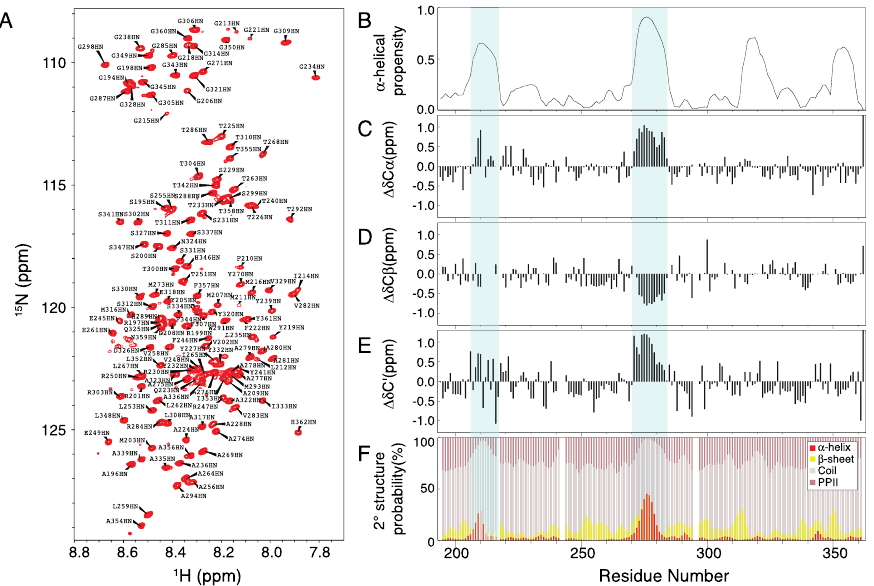
Figure 2. NMR chemical shift assignment of Musashi-1. ( A ) HSQC spectrum of Musashi-1 at 283 K and pH 5.5 with peak assignments. Except L217, Q242, F243, and L319, all non-proline peaks are assigned. ( B ) Residue-specific α-helical propensities predicted using the PASTA program. ( C–E ) Secondary chemical shifts for Cα ( C ), Cβ ( D ), and C’ ( E ) atoms. ( F ) Stacked plot of secondary structure probability based on the assigned chemical shifts, calculated using the δ2D algorithm (red: α-helix; yellow: β-sheet; gray: random coil; brown: polyproline II helix).